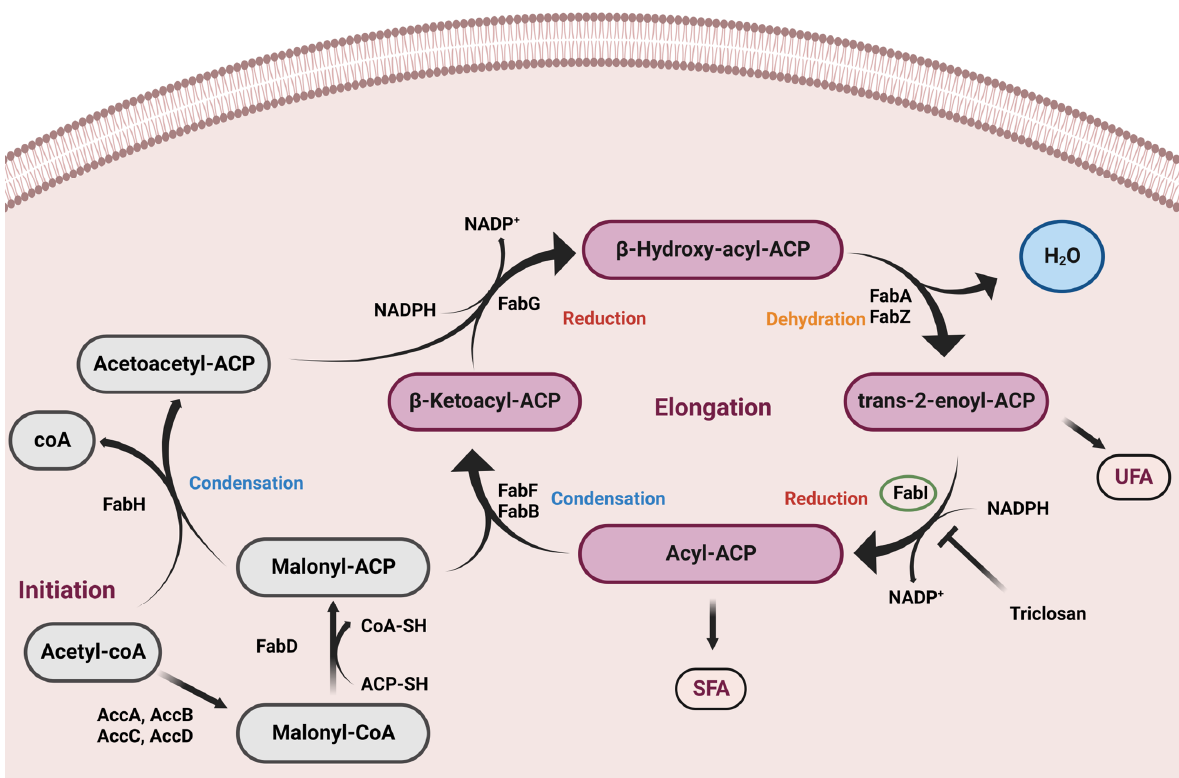
Figure 1. The bacterial biosynthetic cycle of fatty acids. The enzymes malonyl-CoA:ACP transacylase (FabD) and 3-oxooacyl-ACP synthase III (FabH) are involved in initiation of fatty acid synthesis, where 3-oxooacyl-ACP reductase (FabG), enoyl-ACP synthases (FabA and FabZ), enoyl-ACP reductase (FabI), and 3-oxoacyl-ACP synthases (FabB and FabF) are involved in fatty acid elongation. FabI (donated with a green circle) controls the rate of fatty acid synthesis. The inhibition of FabI enzyme will lead to fatty acid synthesis